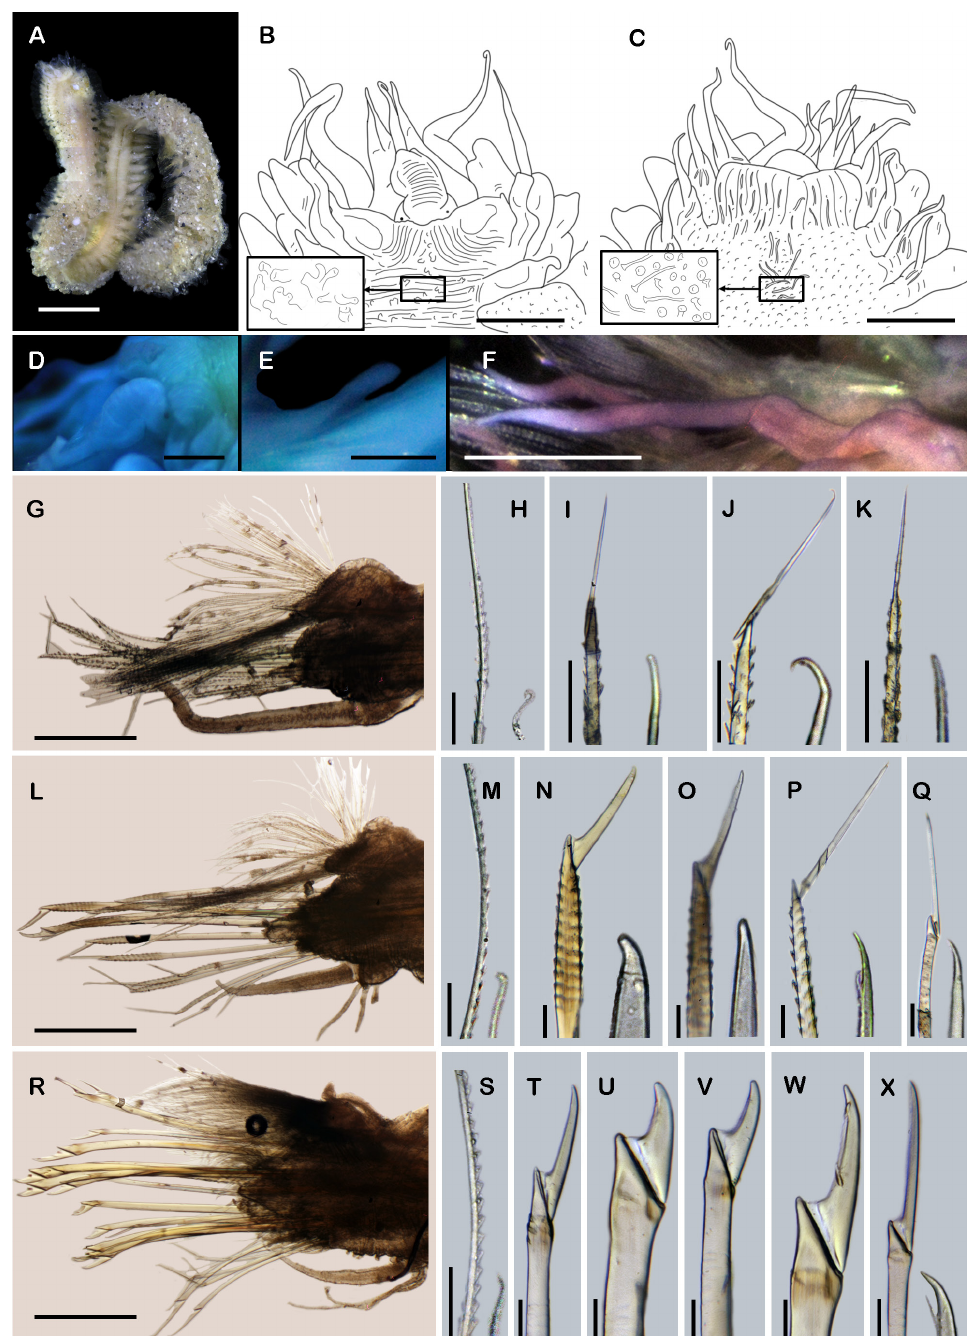
Fig. 17. Pelogenia kinbergi (Hansen, 1882), non-type specimen (UMML 6806-0694). A . Incomplete worm, dorsal view. B . Anterior end, dorsal view (insert: dorsal papillae). C . Anterior end, ventral view, pharynx partially everted (insert: ventral papillae). D . Detail of median antenna ceratophore. E . Lateral antenna. F . Right dorsal cirrus form segment III. G . Right parapodium from segment II. H . Notochaeta from same. I . Unit A. J . Unit B. K . Units C and D. L . Right parapodium from segment III. M . Notochaeta from same. N . Unit A. O . Unit B. P . Unit C. Q . Unit D. R . Right parapodium from segment 21. S . Notochaeta from same. T . Unit A. U . Unit B. V . Unit C. W . Subunit 1. X . Unit D. Scale bars: A = 5 mm; B–C, F = 1 mm; D, G, L, R = 500 μm; E = 200 μm; H, M, S = 40 μm; I–K, N–Q, T–X = 50